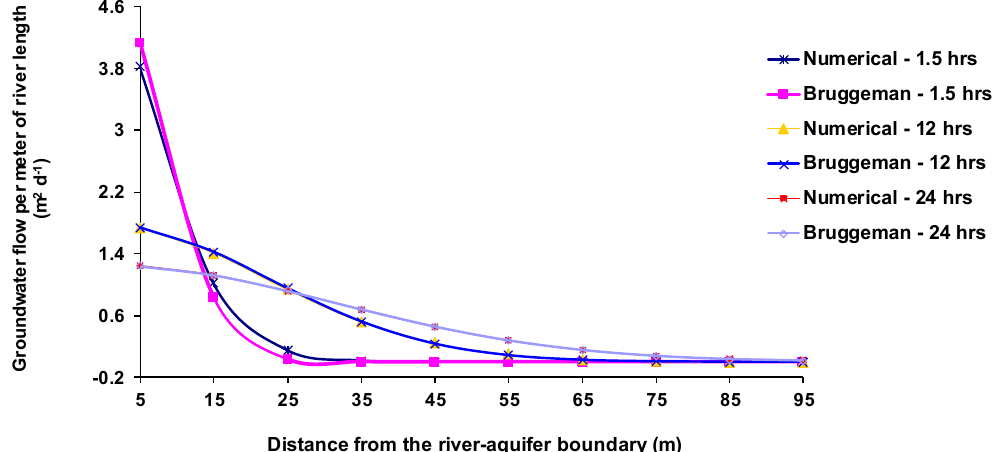
Figure 6. Groundwater fluxes versus lateral distance from river at specific times (1.5, 12, and 24 h) for numerical and Bruggeman [33] solutions for a confined aquifer.